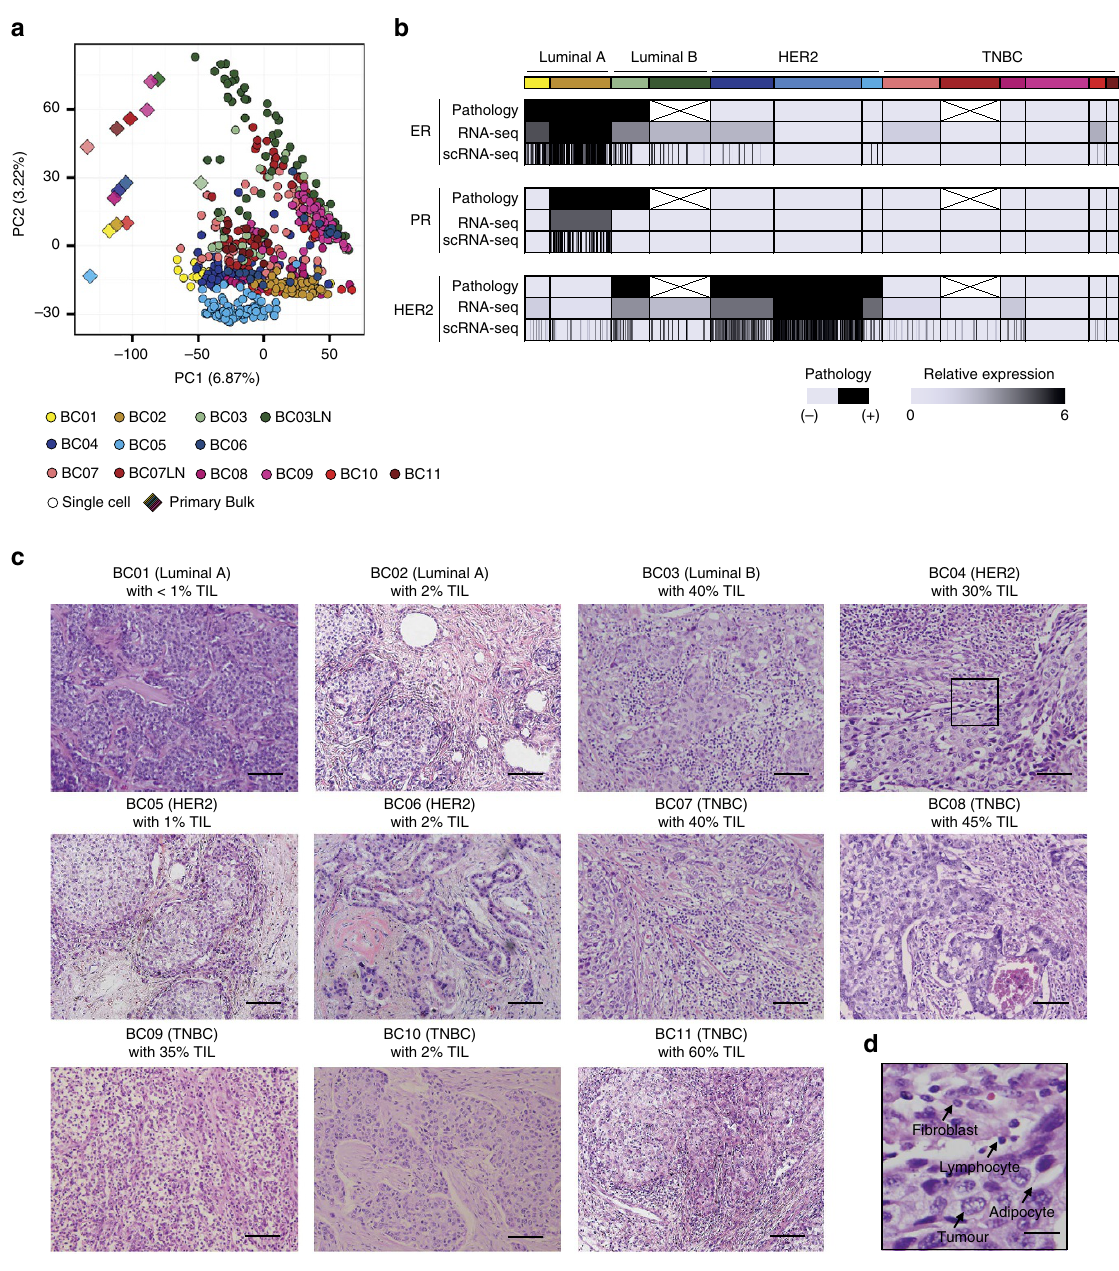
Figure 1 | Intratumoral heterogeneity in primary breast tumours. ( a ) Unsupervised PCA on the transcriptome, indicating a mixed distribution of intra- and interpatient cells. Individual cells are coloured yellow for luminal A, green for luminal B, blue for HER2, and red for TNBC tumours. This colour scheme is maintained throughout the manuscript. ( b ) Individual cells exhibiting gene expression heterogeneity for ER ( ESR1 ), PR ( PGR ) and HER2 ( ERBB2 ). The overall single-cell expression profiles agree with the bulk tumour expression profiles and the pathology results. ( c ) Haematoxylin and eosin staining on formalin-fixed paraffin-embedded slides. Microscopic findings indicated carcinoma and non-carcinoma cells, including tumour-infiltrating lymphocytes 9 (TIL, 1–60%). Most of the TNBC tumours except BC10 were heavily infiltrated with lymphocytes, whereas luminal A tumours showed enrichment with carcinoma cells. Scale bar, 100 m m. ( d ) A part of the tumour tissue in c is magnified to show non-neoplastic cellular components as a representative. Scale bar, 25 m